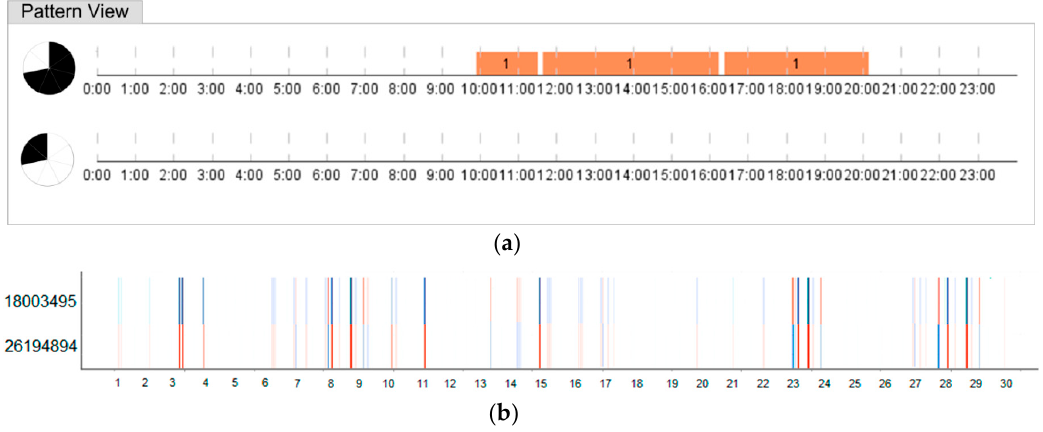
Figure 15. The Employees SOM of the IT department.